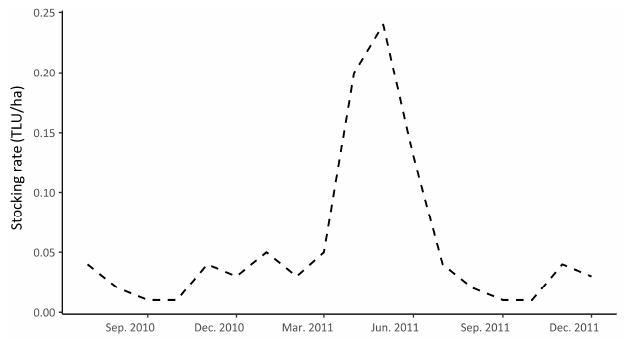
Figure 7. Evolution of livestock at the Agoufou Lake.